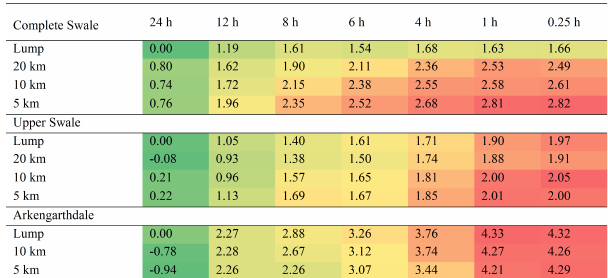
Table 5. The percentage deviations for each catchment of the mean annual hydrological outputs using different spatio-temporal resolu- tions.